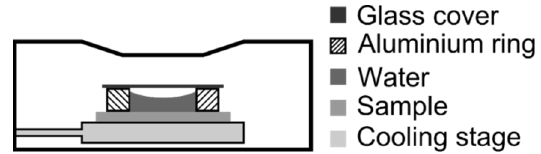
Figure 2. Sketch of cooling-setup (cross section), the neck on top of the cooling